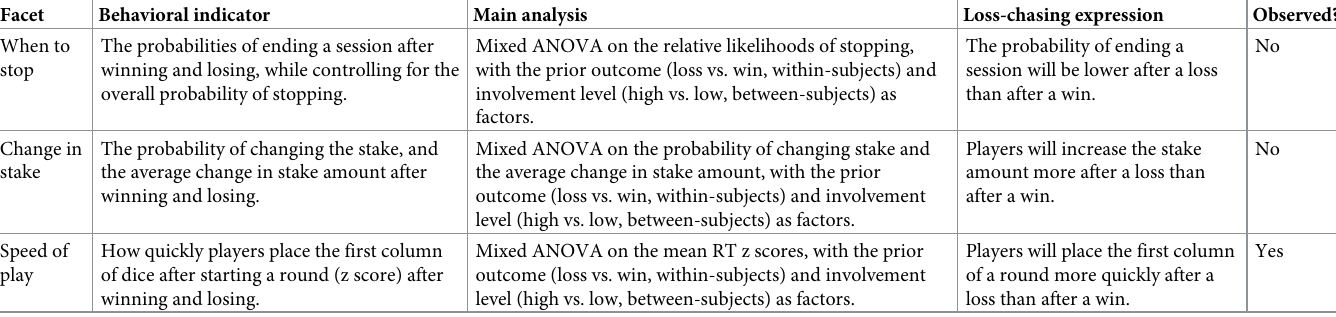
Table 2. An overview of the behavioral indicator, main analysis, loss-chasing expression and whether it was observed in the current study for each facet. Facet Behavioral indicator Main analysis Loss-chasing expression